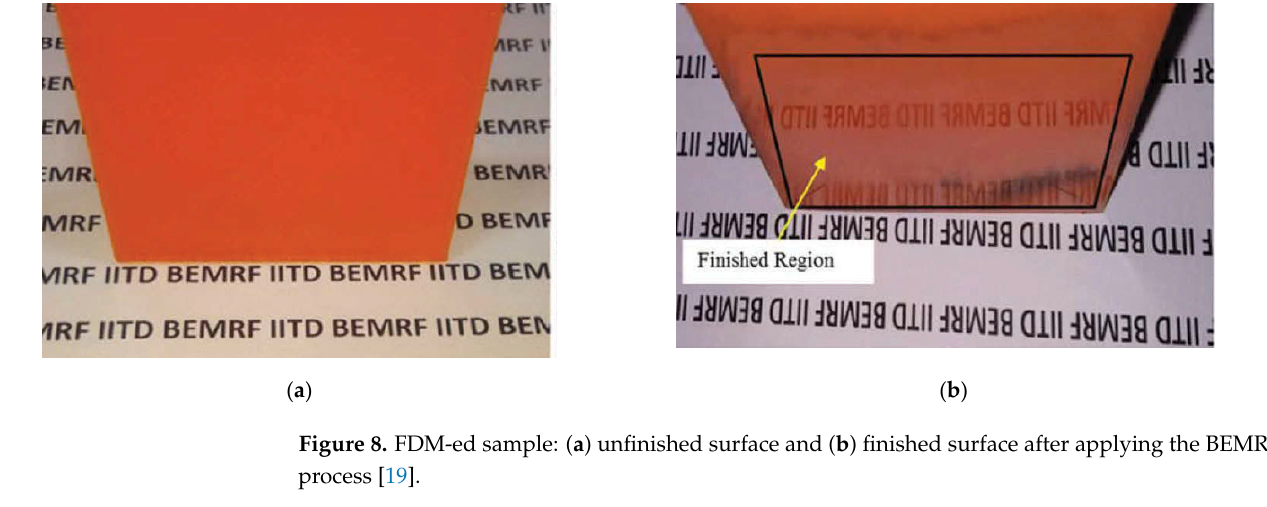
Figure 7. The effect of process parameters in the BEMRF process [19].